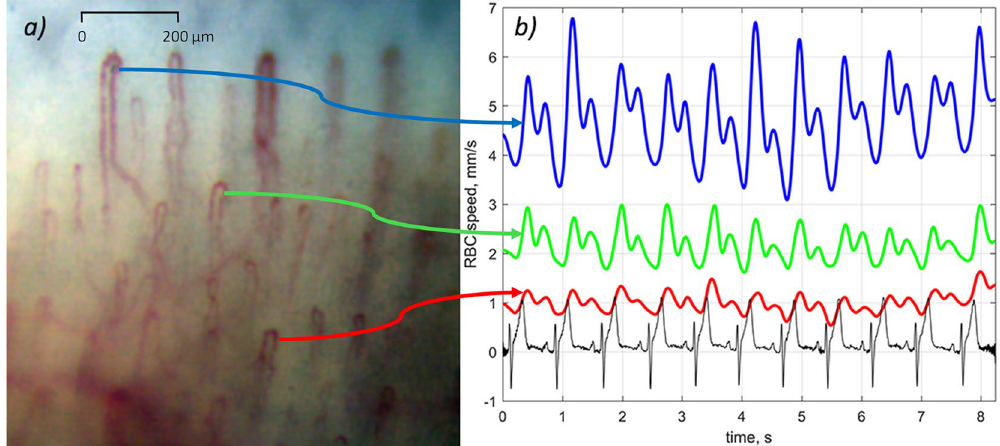
Figure 1. RBC speed modulation in three exemplary capillaries. ( a ) An example of the video capillaroscopy image of finger capillaries. ( b ) RBC speed waveforms (blue, green, and red curves) and simultaneously recorded ECG (black curve). Blue, green, and red arrows connect particular capillaries in which the RBC speed was estimated with the respective